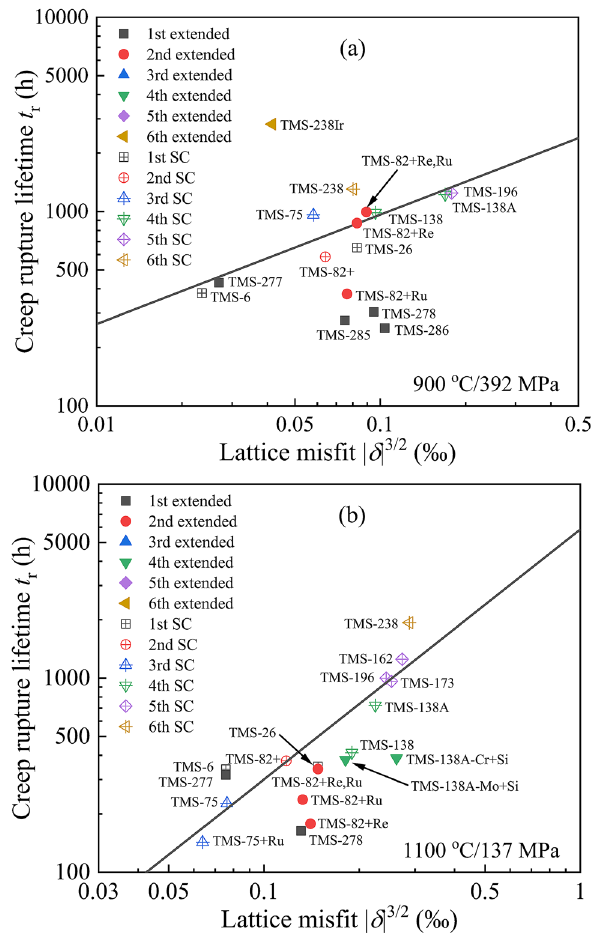
Figure 4. Relationship between the lattice misfit δ and creep rupture lifetime t r of extended brand superalloys with good comprehensive properties at 900 °C/392 MPa ( a ) and 1100 °C/137 MPa ( b ),